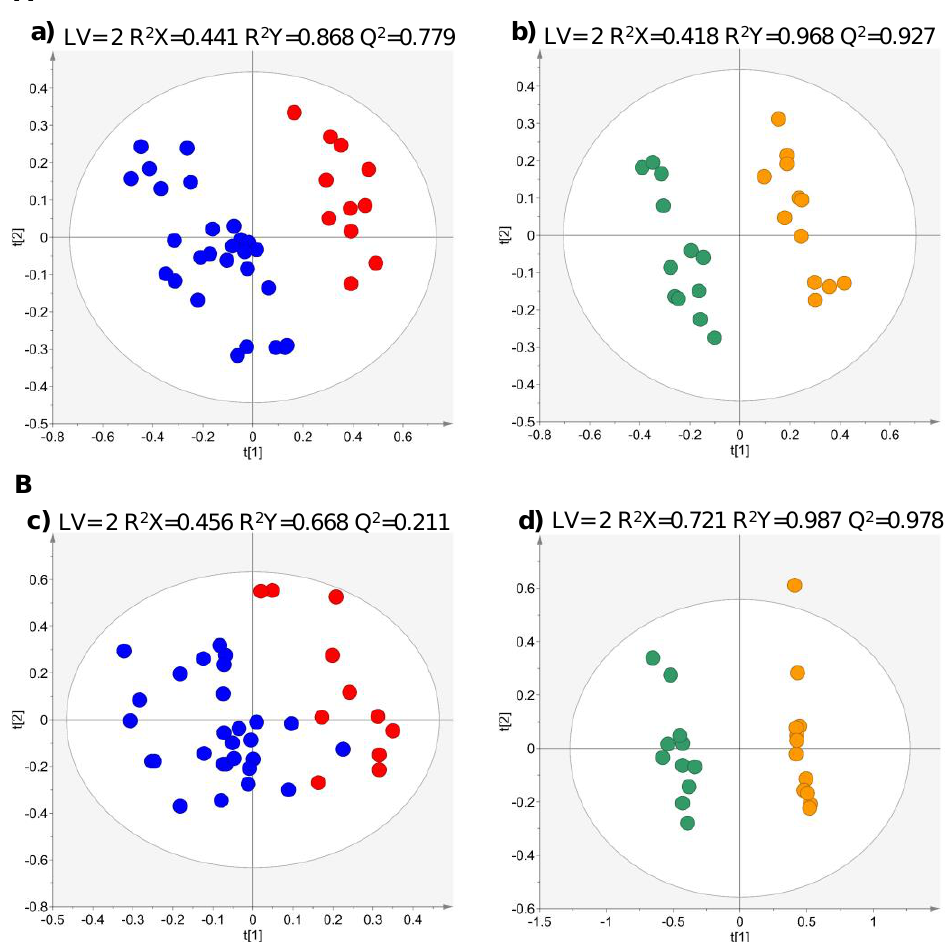
Figure 4. Partial least squares-discriminant analysis (PLS-DA) scores scatter plots obtained for the HS-SPME / GC–MS chromatogram data of ( A ) VOCs and ( B ) VCCs of culture media of the metastatic cell lines vs. non-metastatic cell lines of each RCC histological subtype. ( a , c ) metastatic ccRCC (Caki-1, red, n = 11) vs. non-metastatic ccRCC (769-P and 786-O, dark blue, n = 27) and ( b , d ) metastatic pRCC (ACHN, green, n = 12) vs. non-metastatic pRCC (Caki-2, orange, n =